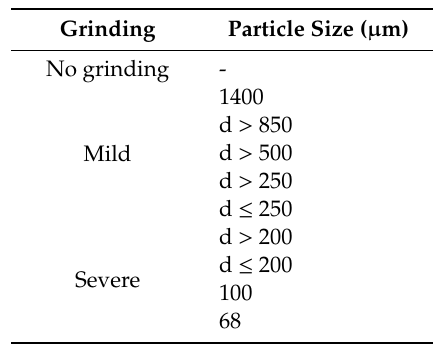
Table 2. Sample particle size of the mild and severe